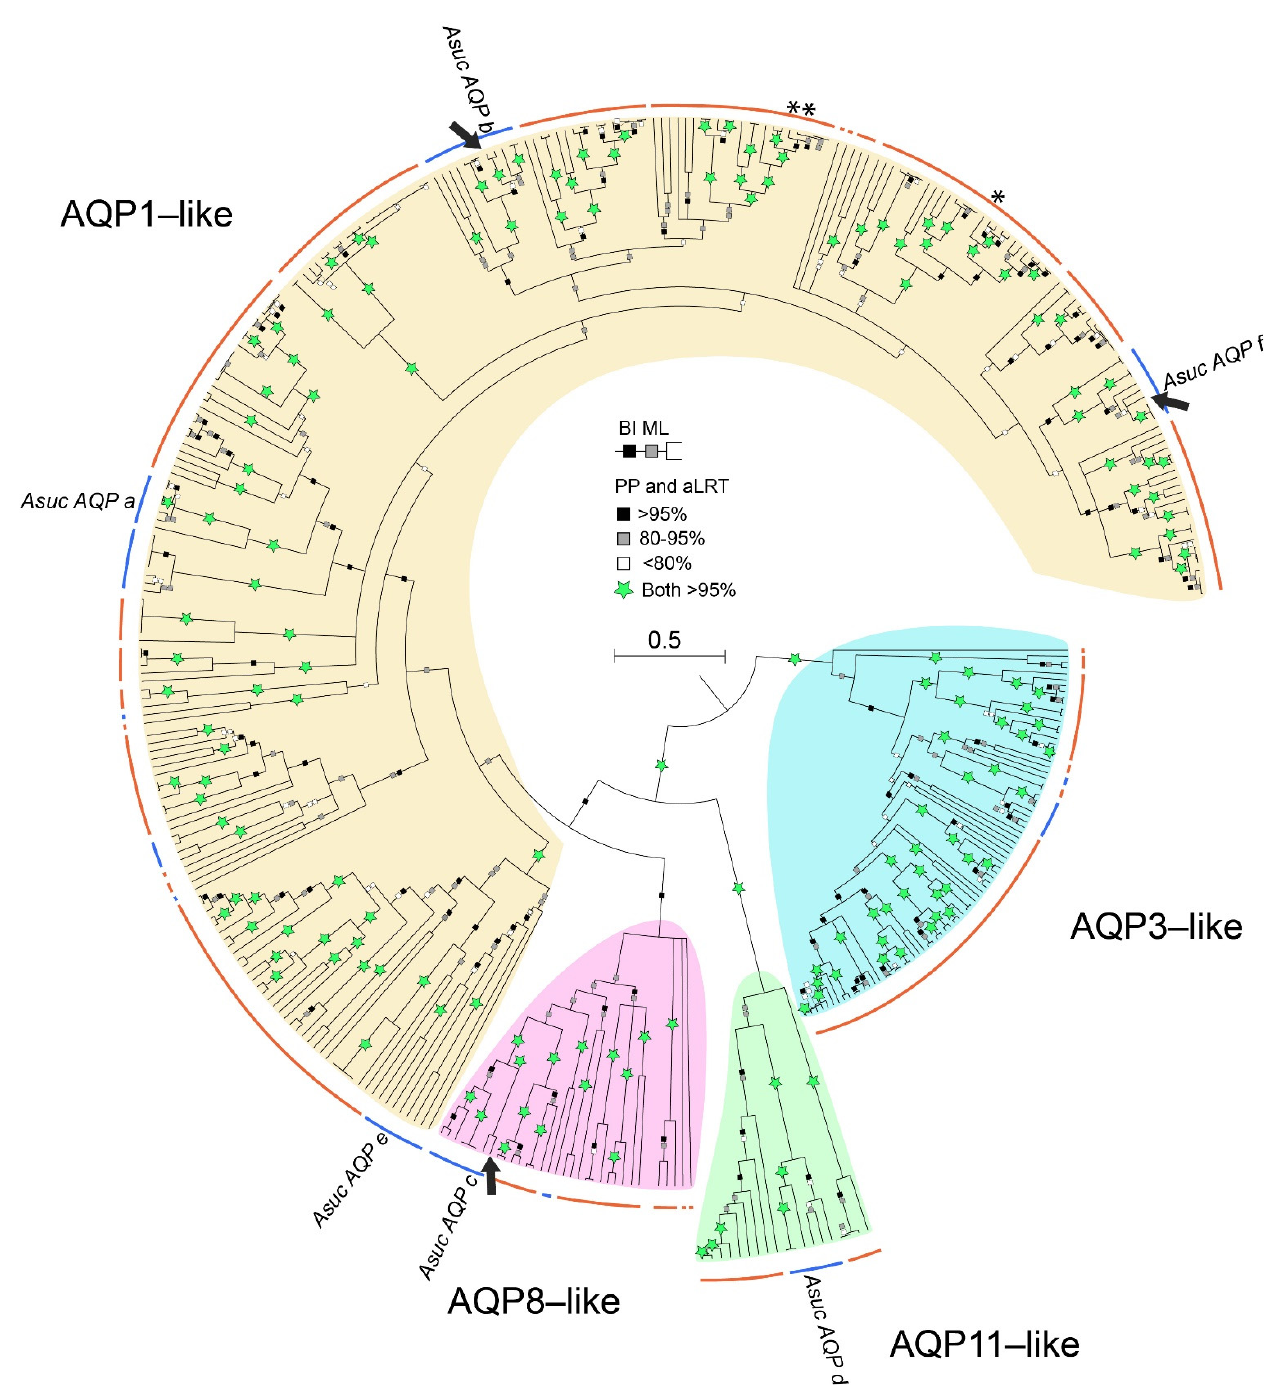
Figure 3. Phylogenetic reconstruction of annelid Aqps . Bayesian tree obtained from 401 sequences, 461 amino acid sites, re-rooted with AQP3-like group. Squares on branches represent the support values for Bayesian inference (BI posterior probabilities; upper square) and maximum likelihood (ML aLRT; lower square) reported as percentages. Nodes < 50% PP collapsed. Labels in the tree refer to the annelid Alitta succinea Aqps ( AsucAQPa, b, c, d, e, f ). Arrows indicate the sequenced AsucAQPs . The asterisk indicates the only three annelids analyzed in [13]. Orange and blue curved lines refer to Sedentaria and Errantia groups, respectively. The fully annotated trees, the alignment and the analyzed sequences are available in the Supplementary Materials (Figures S3 and S4; Data S2; Table S1).